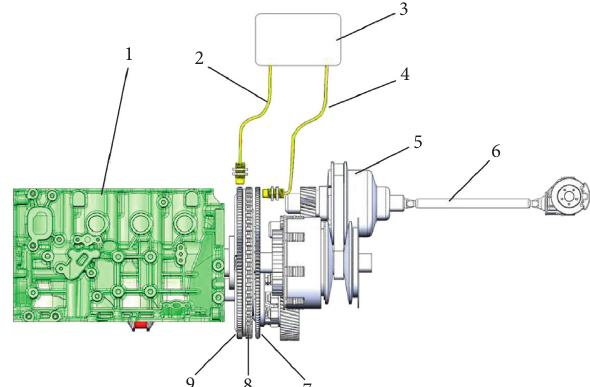
Figure 21: Schematic diagram of electromagnetic rotating speed sensors arrangement. 1, engine; 2, the no. 1 sensor; 3, Siemens data acquisition instrument; 4, the no. 2 sensor; 5, CVT gearbox; 6, transmission shaft; 7, the signal gear on the input shaft of the gearbox; 8, DMF; 9, the signal gear on the primary